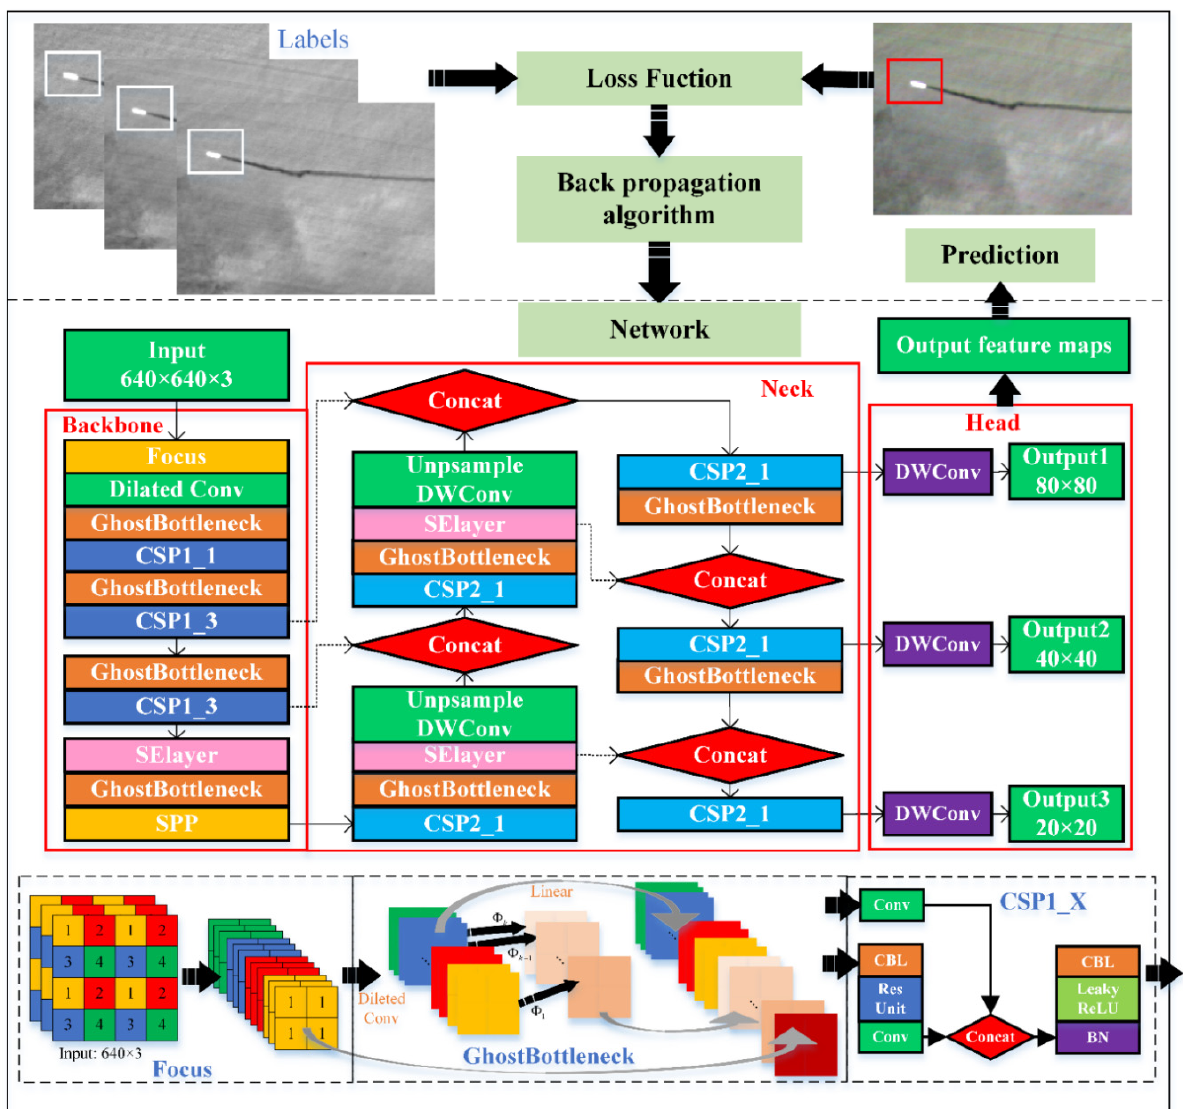
Figure 7. The architecture of proposed all-day ship detection methods (The details of these modules including Focus, Ghost Bottleneck, and CSP1_X are shown at the bottom).